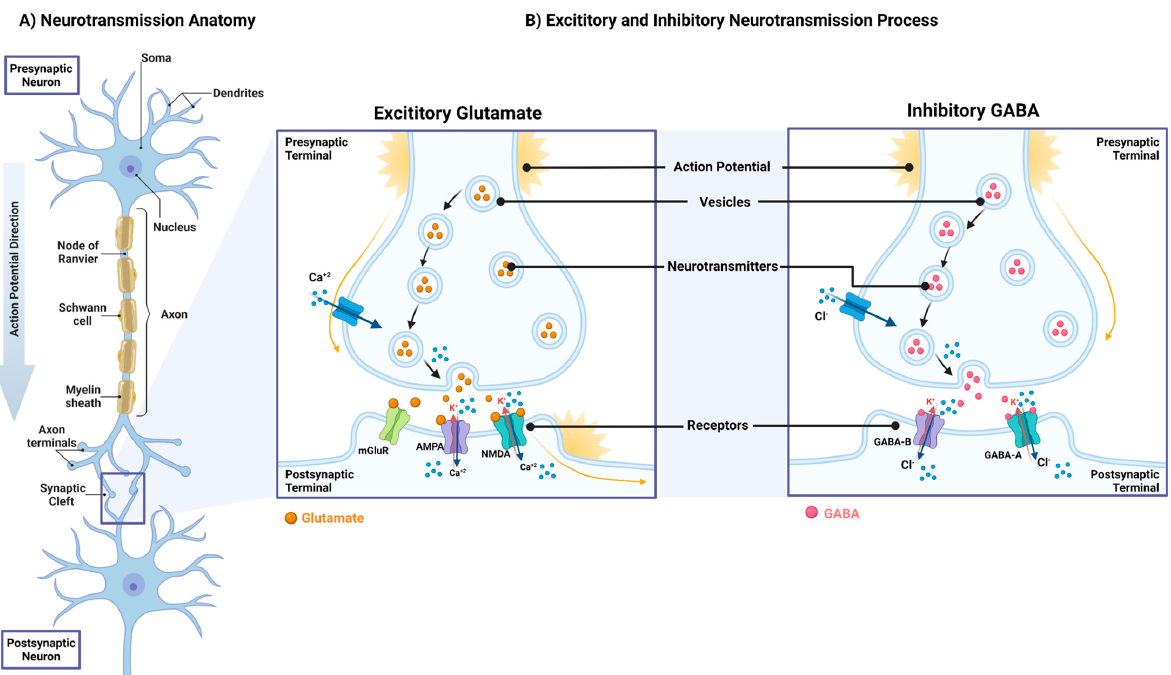
Figure 1. Neurotransmission anatomy and process. ( A ) Neurotransmission anatomy: An action potential moves along the axon of the presynaptic neuron to interact with the dendrites of the postsynaptic neuron creating a synaptic cleft in which the neurotransmission process occurs. ( B ) Excitatory and inhibitory neurotransmission process: Neurotransmitters are stored in vesicles in the presynaptic terminal and are released upon the receipt of an action potential that triggers the release of different ions (i.e., Ca 2+ , Cl − , K + ) and neurotransmitters (i.e., excitatory glutamate and inhibitory GABA) which activates different receptors depending on the synaptic activity. Abbreviations: Ca 2+ : calcium ions; K + : potassium ions; mGluR: metabotropic glutamate receptor; AMPA: α -amino-3-hydroxy-5-methyl-4-isoxazole propionic acid receptor; NMDA: N-methyl-D-aspartate receptor; Cl − : Chloride ions; GABA A and GABA b : γ -Aminobutyric acid receptors ( A , B ), respectively. Created with BioRender.com. Glutamate, Gamma-aminobutyric acid (GABA), dopamine, serotonin, norepinephrine, and acetylcholine are of clinical relevance and are the most studied